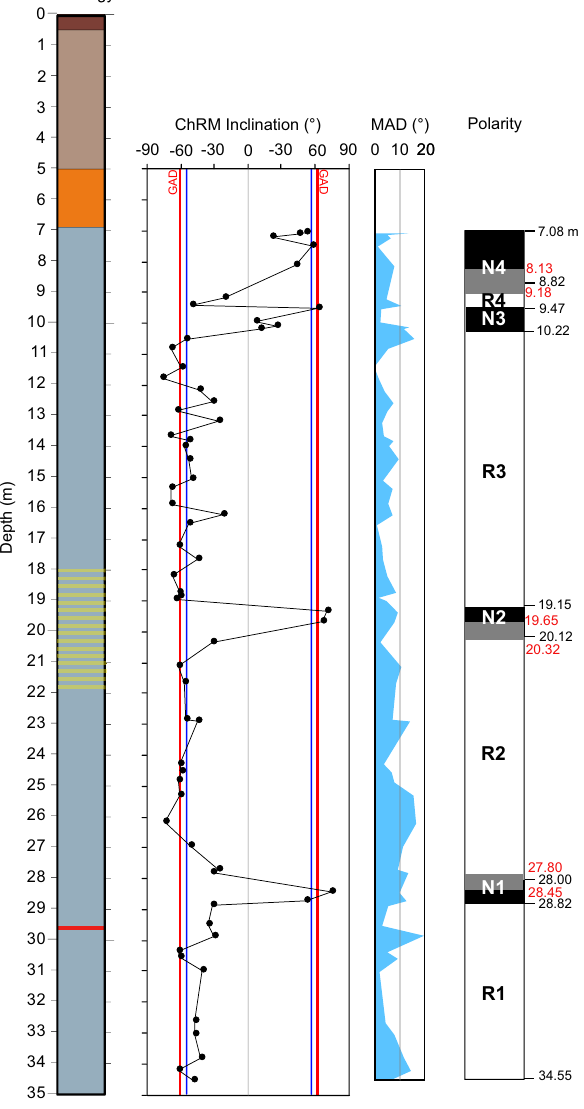
Figure 6. Lithology (symbols as in Fig. 3), downcore variations of ChRM inclination, MAD, and magnetic polarity zonation (black = normal polarity and white = reverse